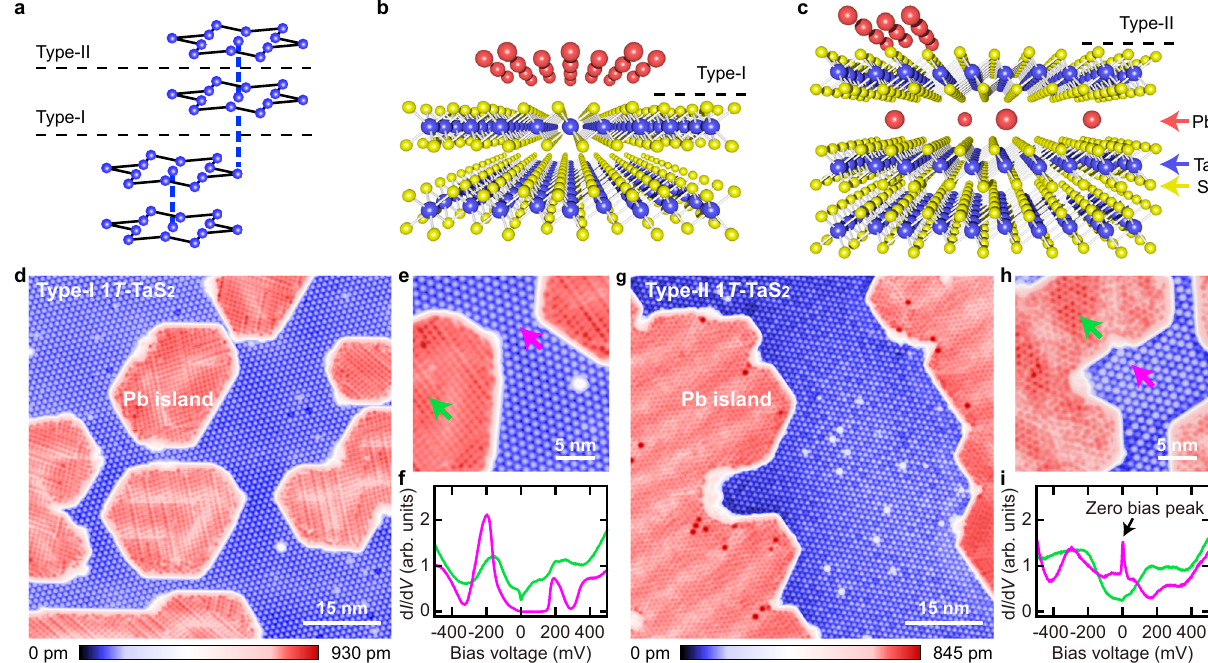
Fig. 1 Emergence of the zero bias peak in the Pb intercalated 1 T -TaS 2 . a Schematic showing the alternating interlayer stacking of the SD clusters in 1 T - TaS 2 which results in two inequivalent cleavage planes. b Schematic for the structure of the Type-I surface after evaporating Pb atoms. c Schematic for the structure of the Type-II surface after evaporating Pb atoms. The red, blue and yellow balls in b , c represent the Pb, Ta and S atoms, respectively. d Constant-current STM topography taken on the Type-I surface ( V s = − 500 mV, I = 20 pA). e Zoom-in view of the bare Type-I surface and Pb islands ( V s = − 500 mV, I = 20 pA). f Differential conductance (d I /d V ) spectra taken on the spots indicated by the purple and green arrows shown in e . g Constant-current STM topography taken on the Type-II surface ( V s = − 500 mV, I = 30 pA). h Zoom-in view of the bare Type-II surface and Pb islands ( V s = − 500 mV, I = 20 pA). i d I /d V spectra taken on the spots indicated by the purple and green arrows in h . The data shown in this fi gure are taken at T = 4.3 K. Source data are provided as a Source Data fi le.